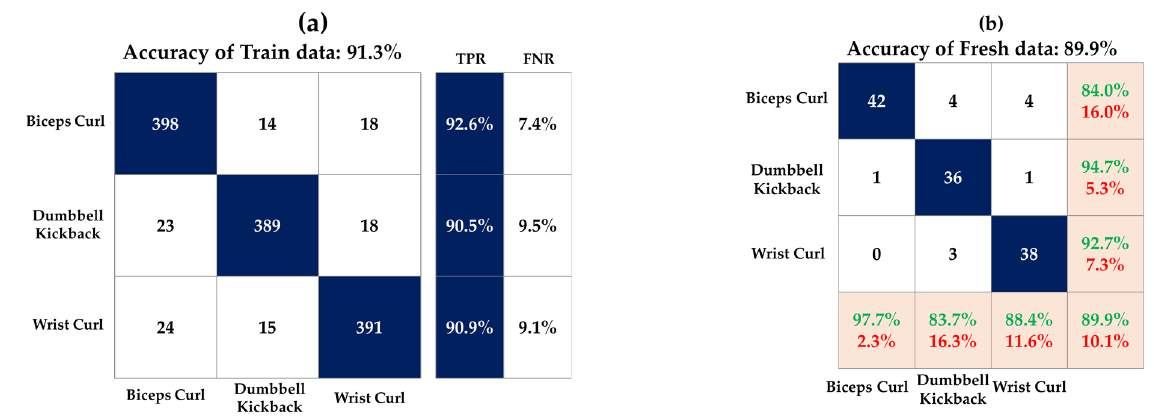
Figure 12. Confusion matrix of SVM model on ( a ) train data and ( b ) test data.